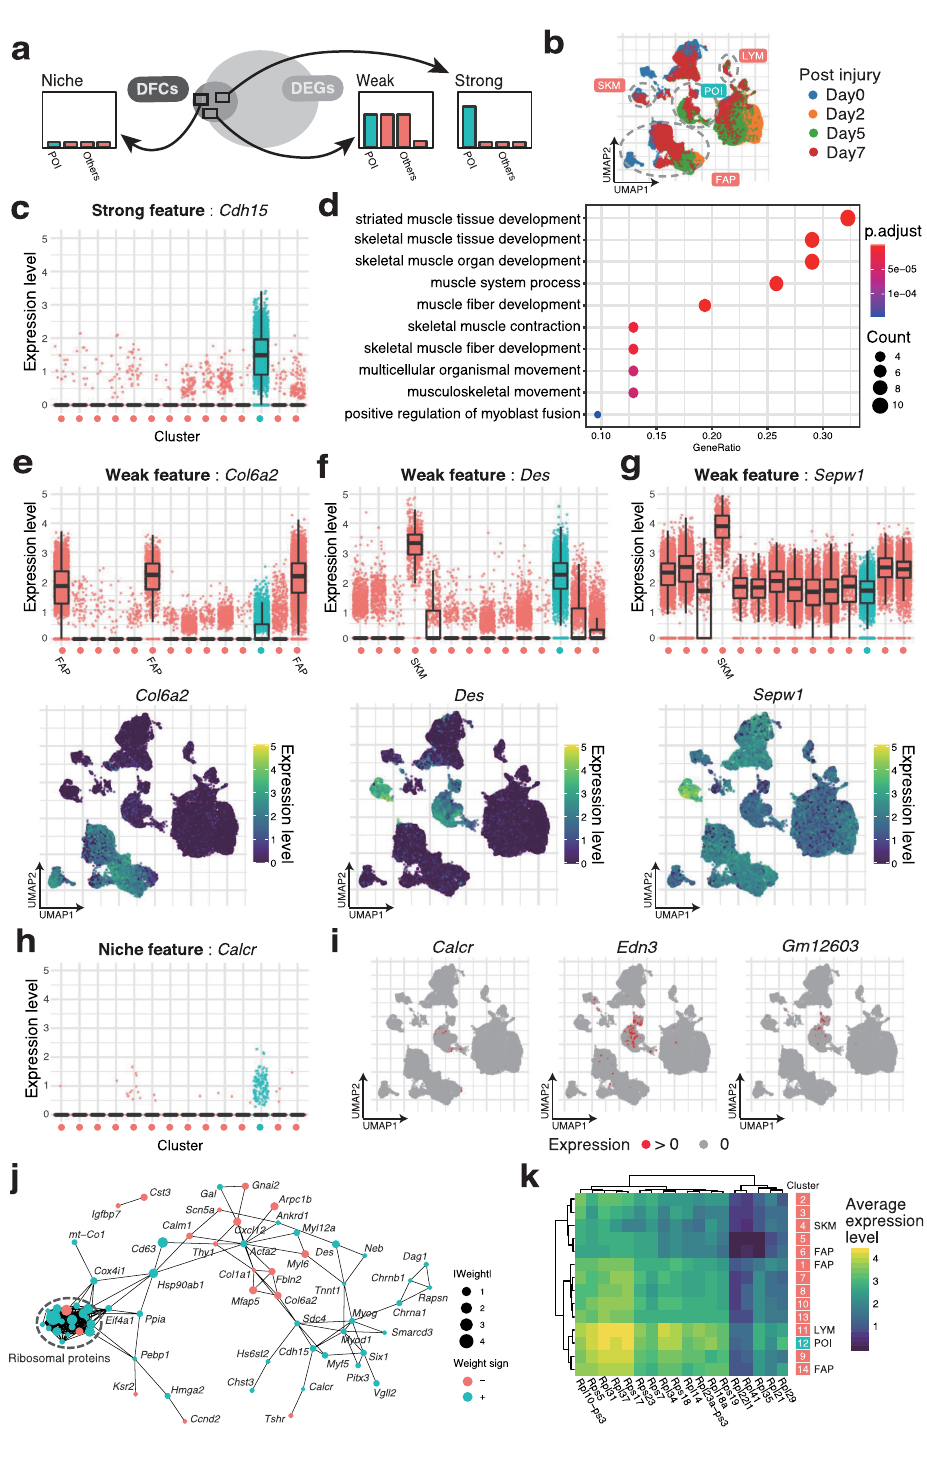
Fig 3. Biological significance of genes in DFC revealed by the discriminative ability. (a) According to the specificity of the expression, the genes in DFC are classified into three groups. The three groups are named Strong (specific to 1–2 clusters), Weak ( > 2), and Niche features (none of them). (b) The data are from samples collected at 0, 2, 5, and 7 days after skeletal muscle injury. In addition, the clusters of fibro/adipogenic progenitors (FAPs), mature skeletal